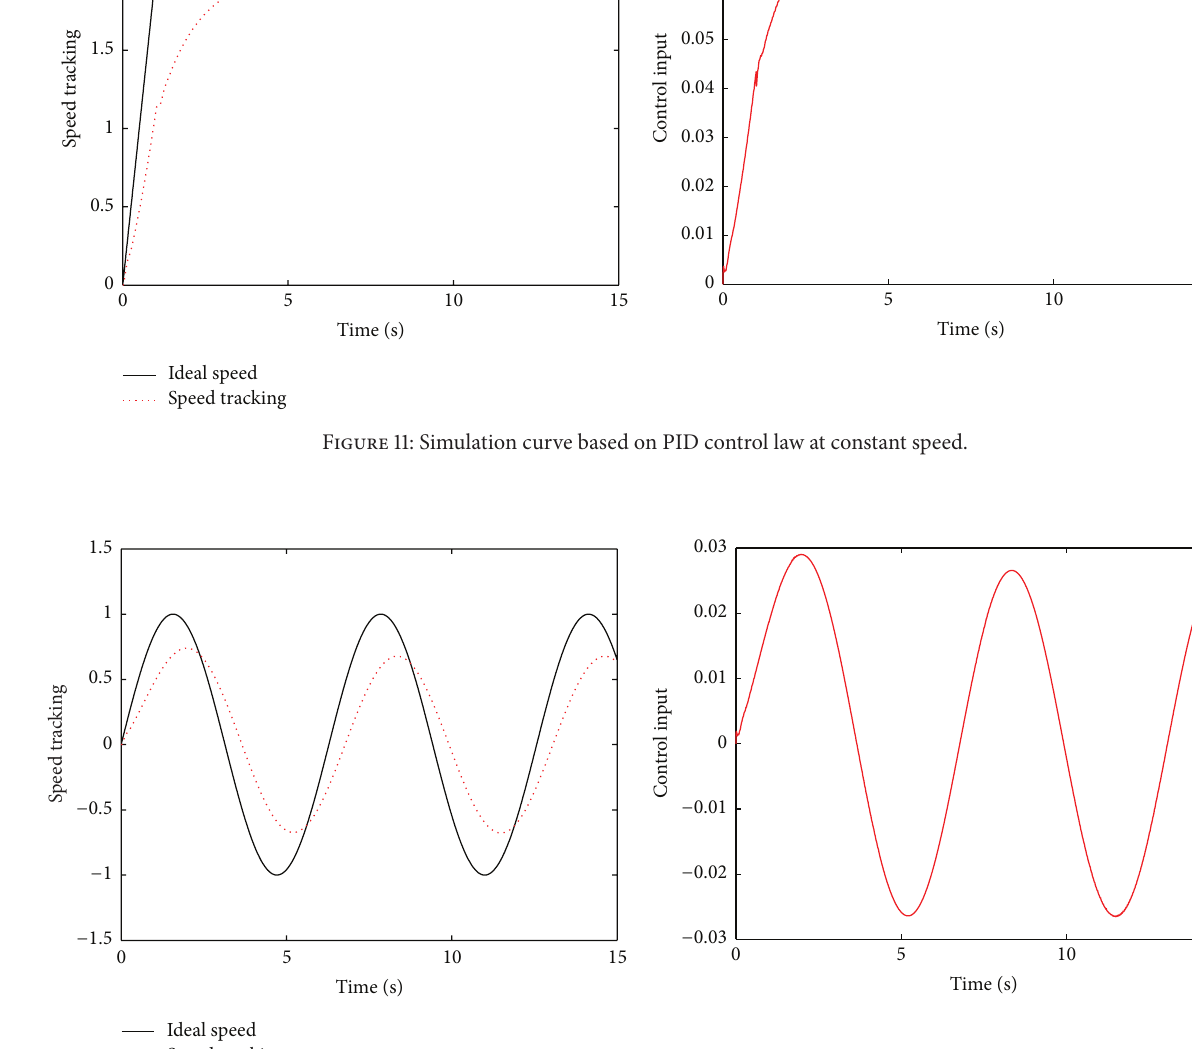
Figure 12: Simulation curve based on PID control law at variable